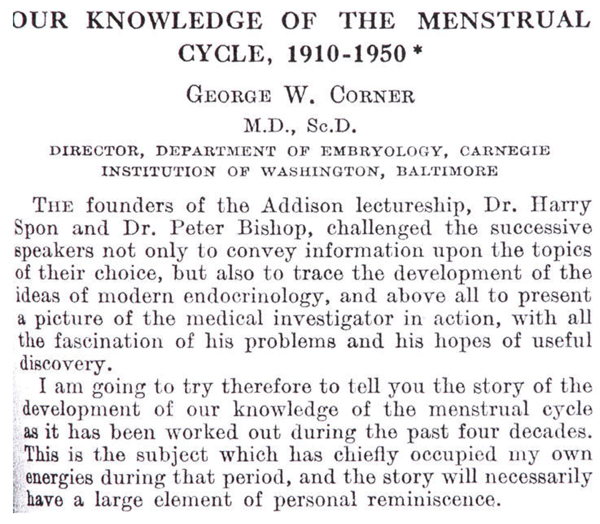
A manuscript by the brilliant scientist and humanist G.W. Corner, the discoverer of progesterone, that summarizes studies on menstruation during the first half of the 20th century [10].